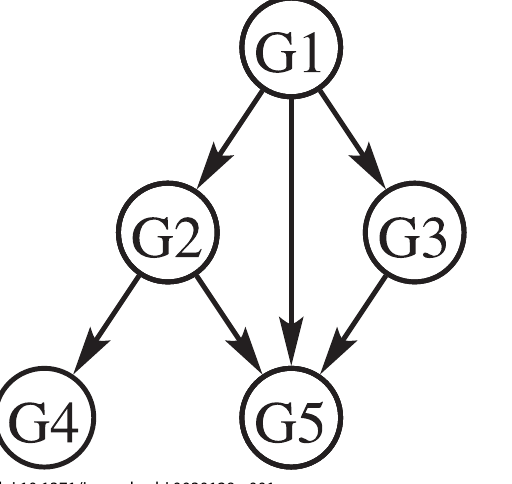
Figure 2. Illustration of Model Parameters for Two-Node Bayesian Network